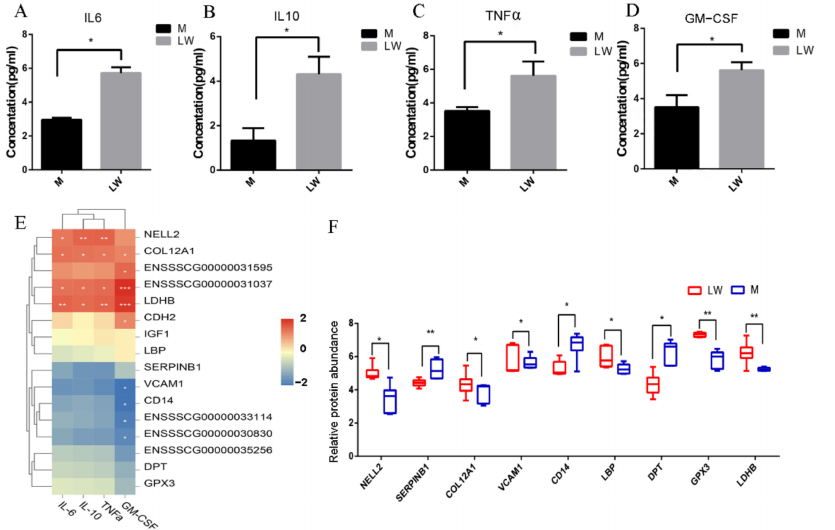
Figure 7. Quantification of cytokine and protein expression abundance. ( A – D ) Quantification val- idation of cytokines. ( E ) Correlation matrix of the expression levels of the proteins and cytokines. ( F ) Quantification validation of proteins by PRM. *: p -value < 0.05; **: p -value <